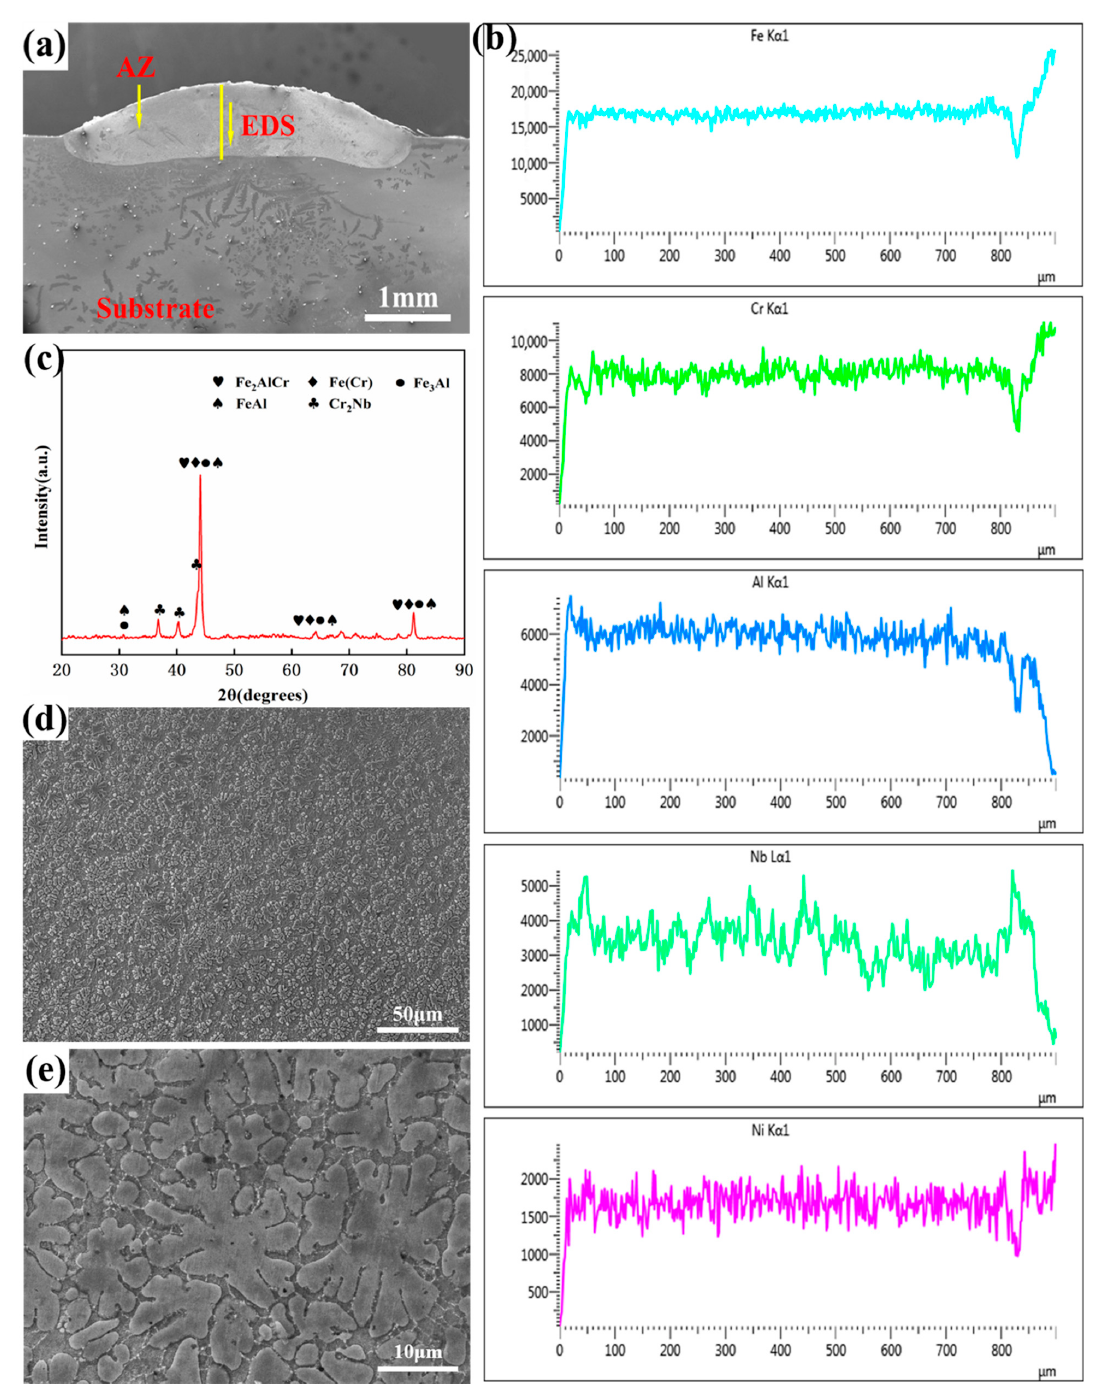
Figure 2. AZ macroscopic morphology and microstructure: ( a ) single-pass AZ cross-sectional mor- phology, ( b ) EDS line scan result, ( c ) AZ surface XRD pattern, ( d , e ) AZ